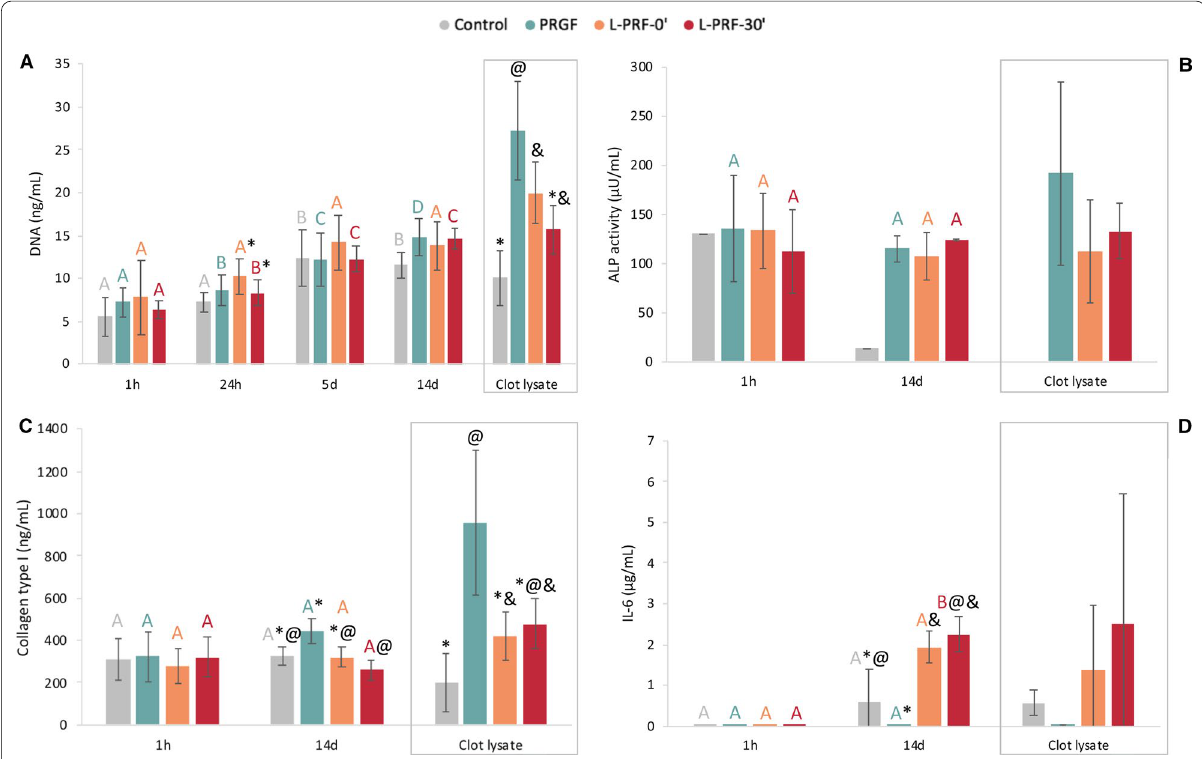
Fig. 4 A Osteoblast proliferation in terms of DNA release in ng/mL. B ALP activity in μU/mL. C Collagen type I in ng/mL. D IL‑6 secreted by osteoblasts in μg/mL. Letters indicate intragroup non‑statistically significant differences between two consecutive times. Differences within groups are identified with a symbol. Comparisons of ALP activity could not be stablished on the clot lysate because of a lack of sample on the control